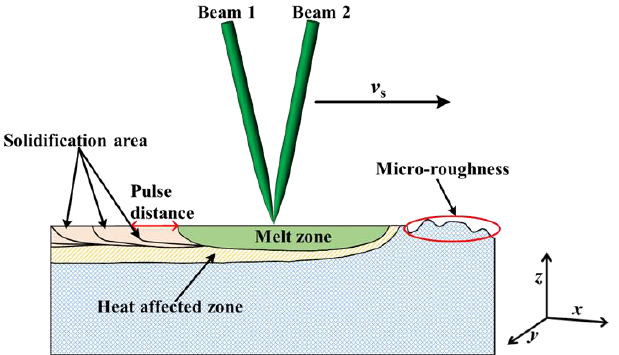
the eccentricity of the elliptical spot increases. spot increases.